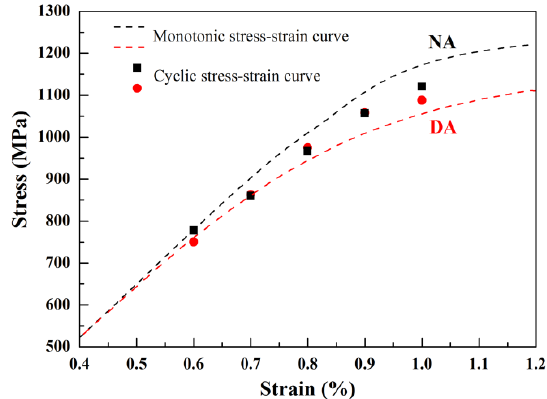
Figure 7. Cyclic stress–strain scatters and the corresponding monotonic stress–strain curves for NA and DA alloy.